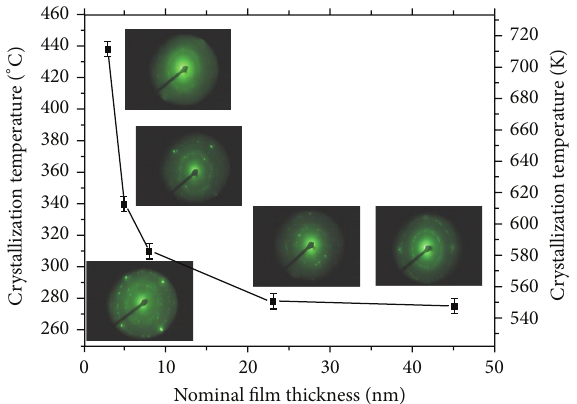
Figure3:Crystallizationtemperatureversusnominalfilmthickness of In 2 Se 3 in nanopit substrate. Insets are diffraction pattern of the polycrystallinediffractionringsforeachcrystallizationtemperature.